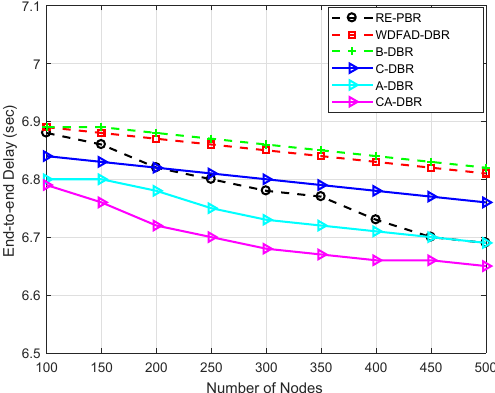
Figure 8. Comparison of end-to-end